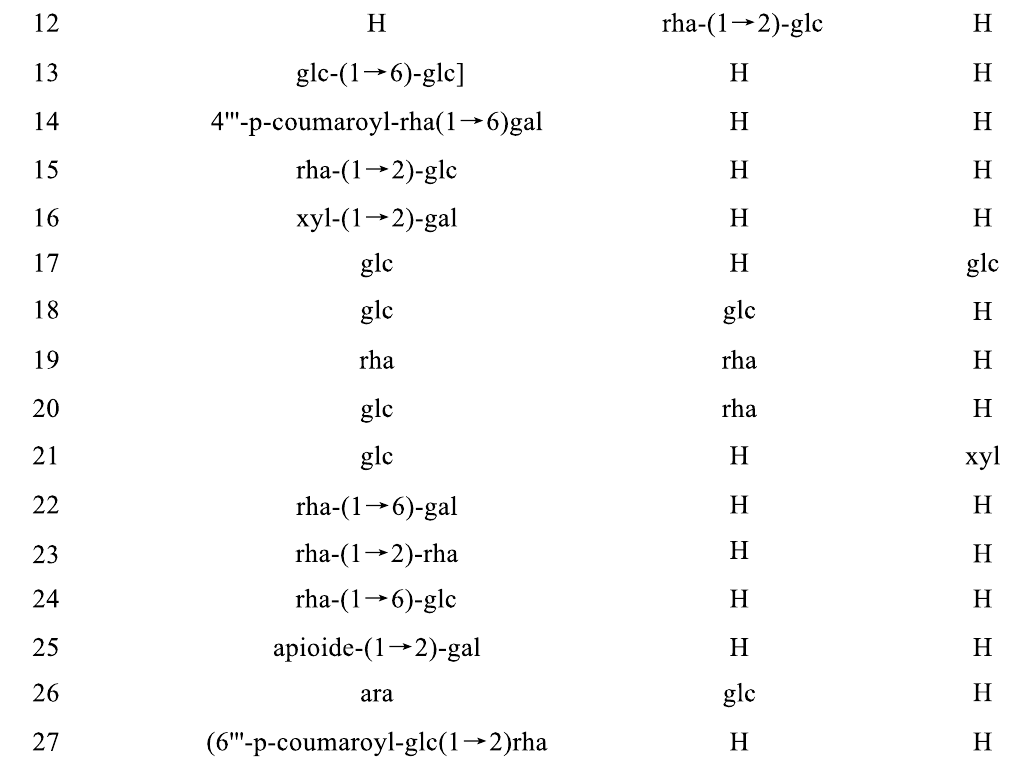
Figure 2. Chemical structures of IGs (compounds 1 – 49 ). Monoglycosides ( 1–9 ), diglycosides ( 10–34 ), triglycosides ( 35–48 ), and tetraglycosides ( 49 ). Abbreviations: Glc: D-glucose, Rha: L-rhamnose, Glccur: D-glucuronic, Gal: D-galactose, Xyl: D-xylose, Ara: L-arabinose. Abbreviations: Glc: D - glucose, Rha: L -rhamnose, Glccur: D -glucuronic, Gal: D -galactose, Xyl: D -xylose, Ara: L